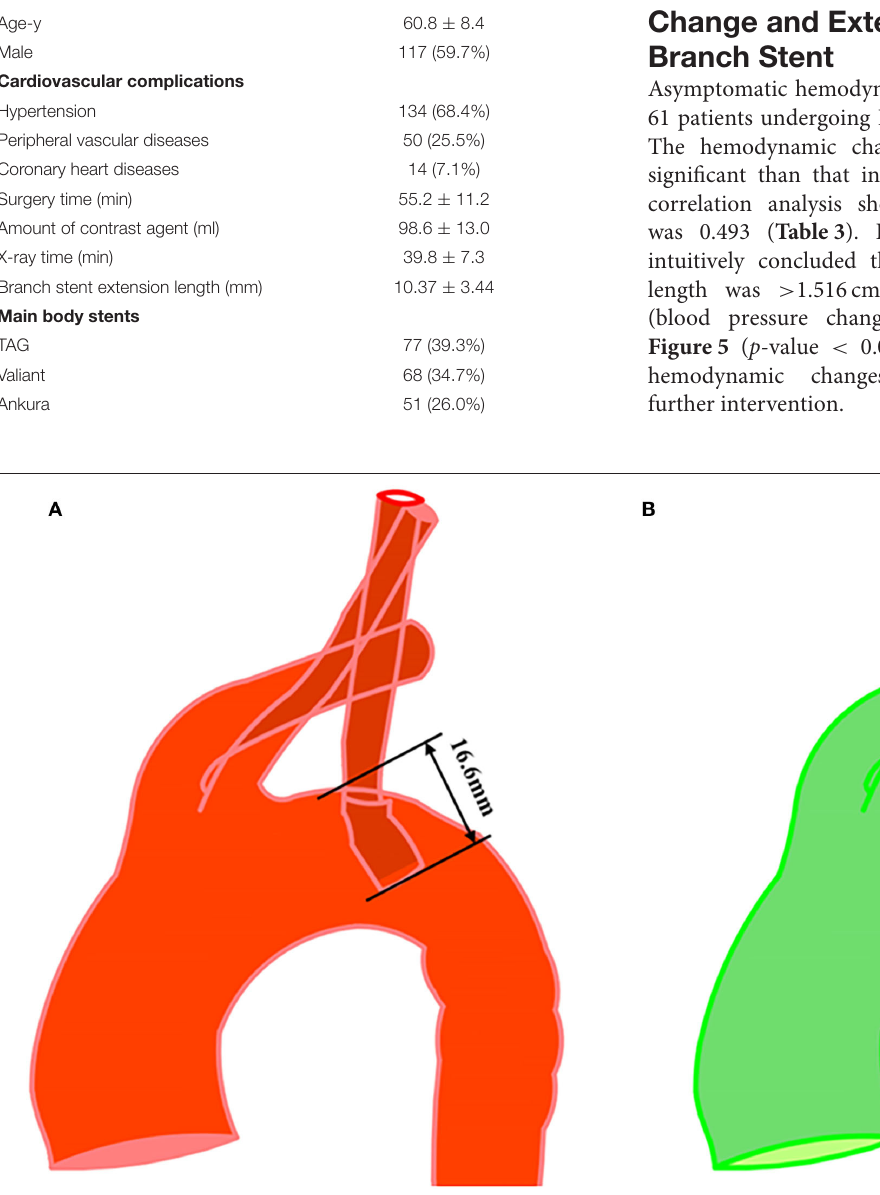
FIGURE 4 | Measurement of branch stent protrusion length. (A) Maximum value (16.6mm) and minimum value (3.1mm) were shown in postoperative geometry with in situ fenestration. (B) The observer’s sight was perpendicular to the plane where the branch stent was located.